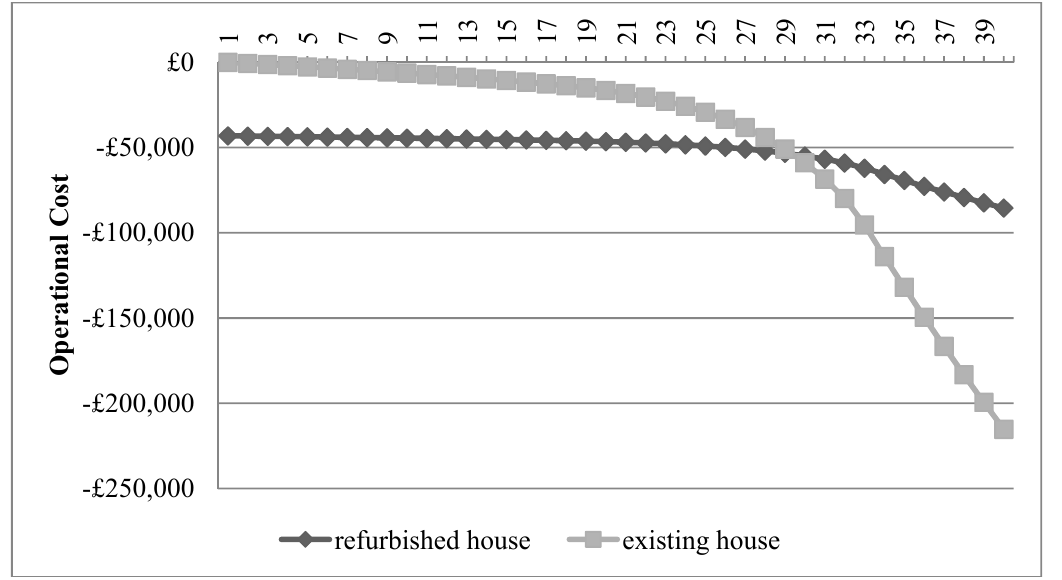
Figure 20. Comparison of the pre and post refurbished house’s cumulative discounted operational costs for Manchester current and future weather data over 40 years imposing an upward gas price